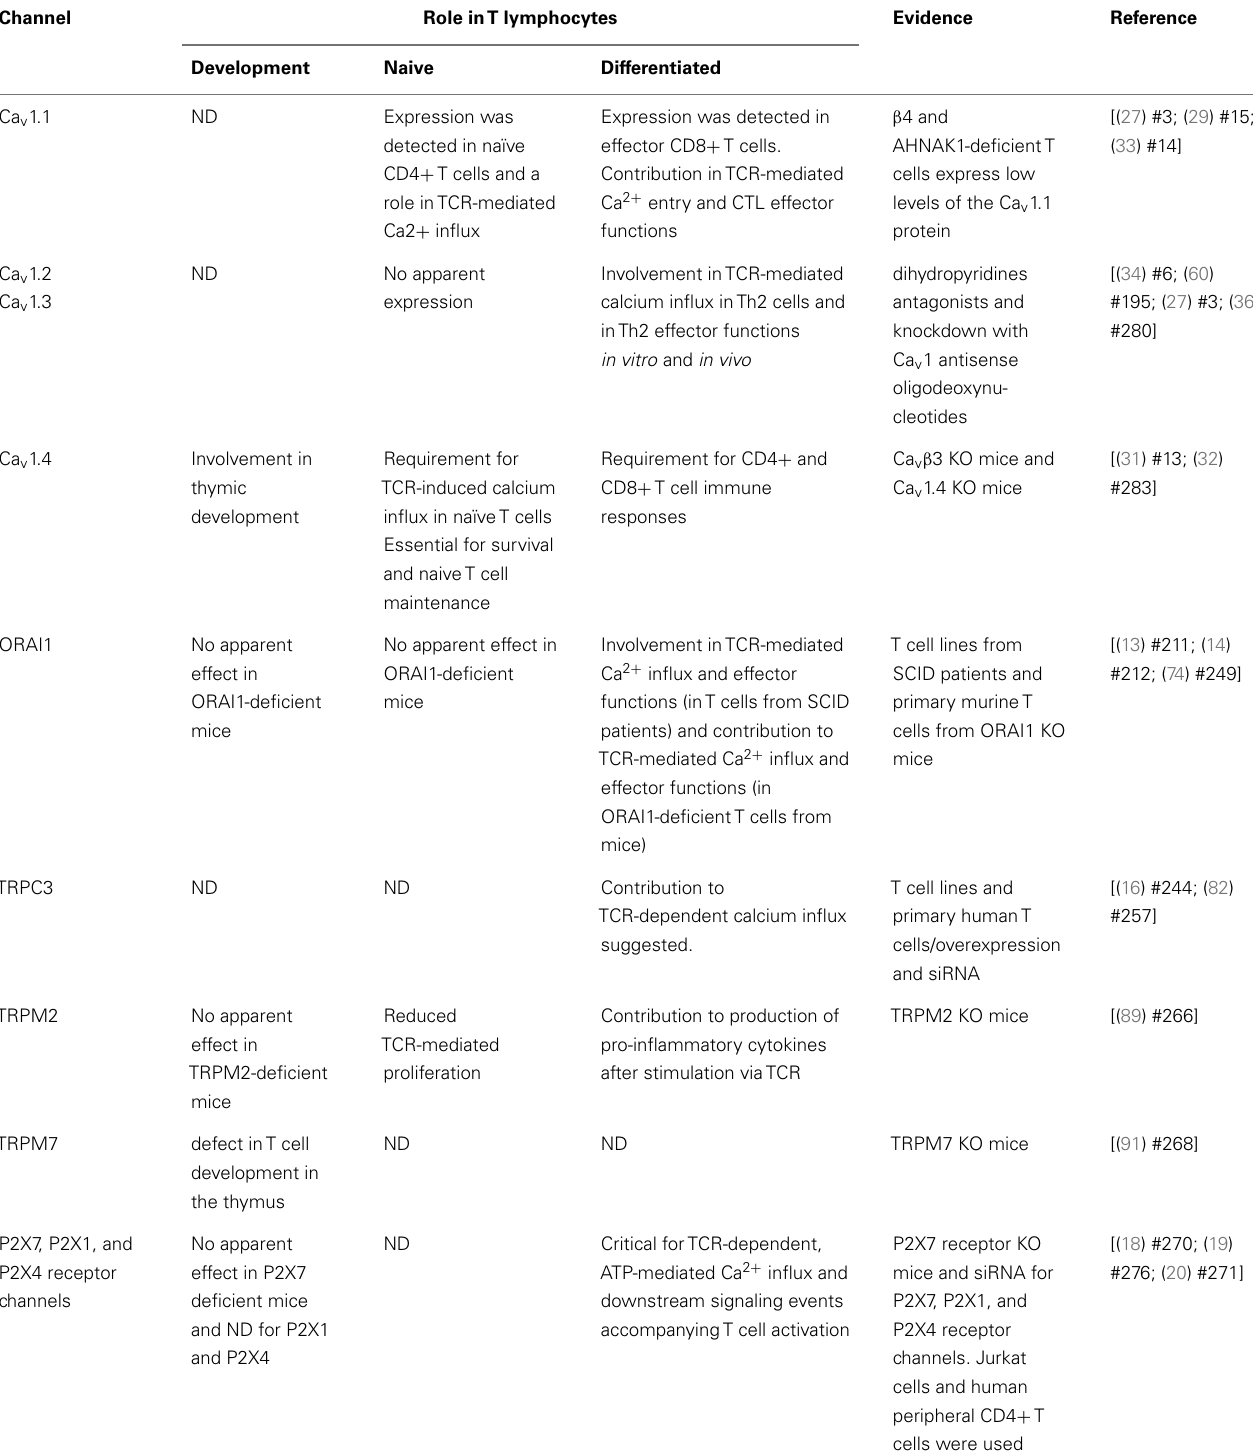
Table 1 | Role of distinct Ca 2 + -permeable channels inT lymphocyte development and functions.